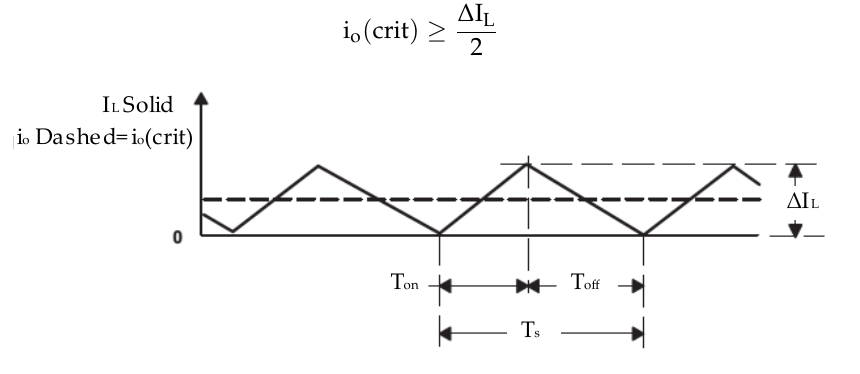
Figure 4. Critical output current.